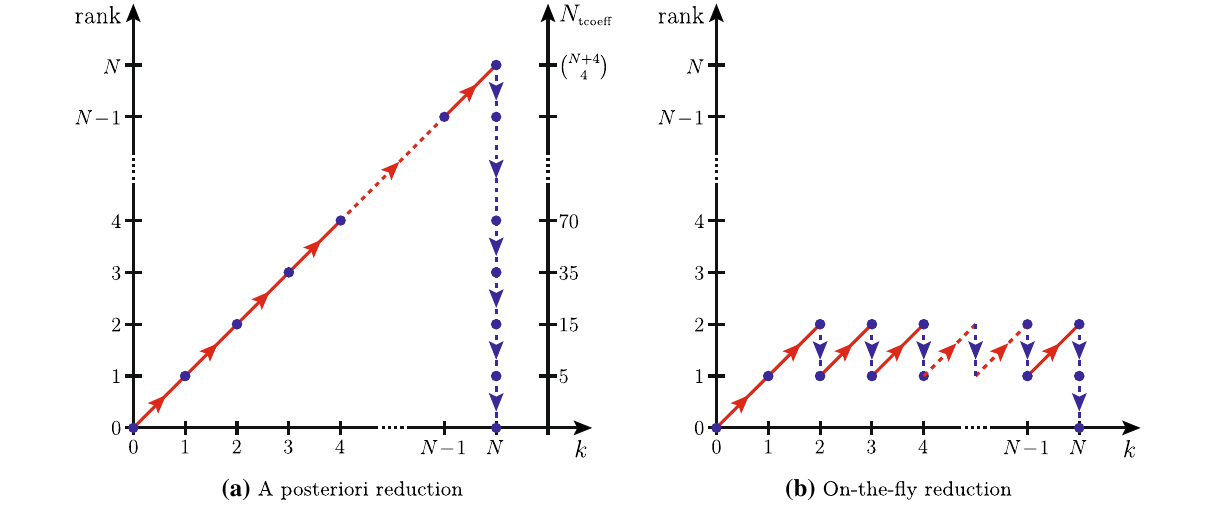
Fig. 6 Evolution of the tensor rank R and the number N tcoeff ( R ) = (cid:31) R + 4 of open-loop tensor coefficients (right vertical axis) as a function 4 of the number k of dressed segments during the open-loop recursion. Each dressing step is assumed to increase the rank by one. The origi-